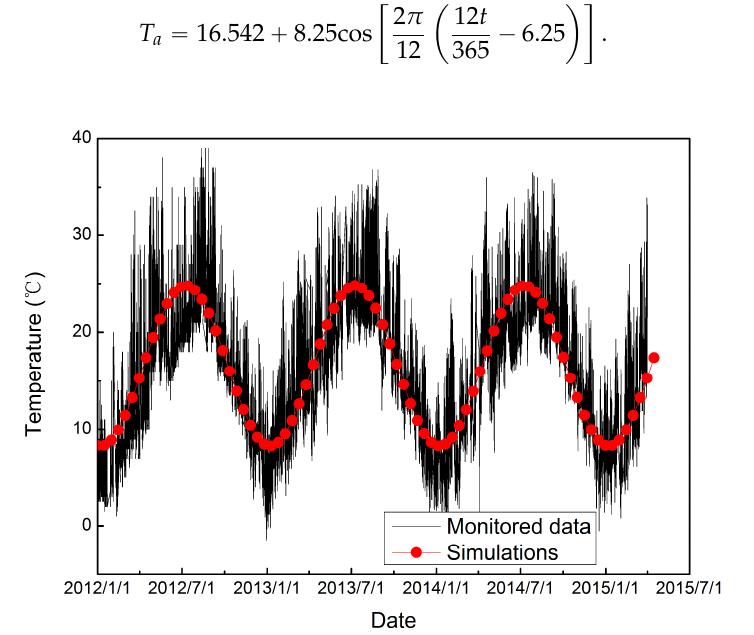
Figure 10. Monitored and simulated air temperature values.